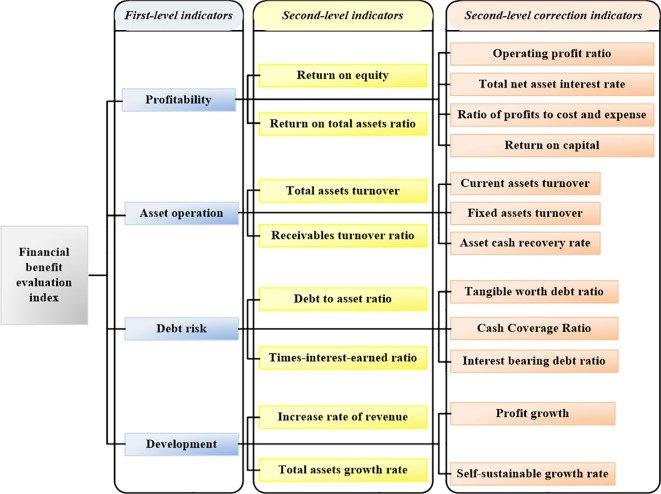
Comprehensive performance financial index evaluation system.